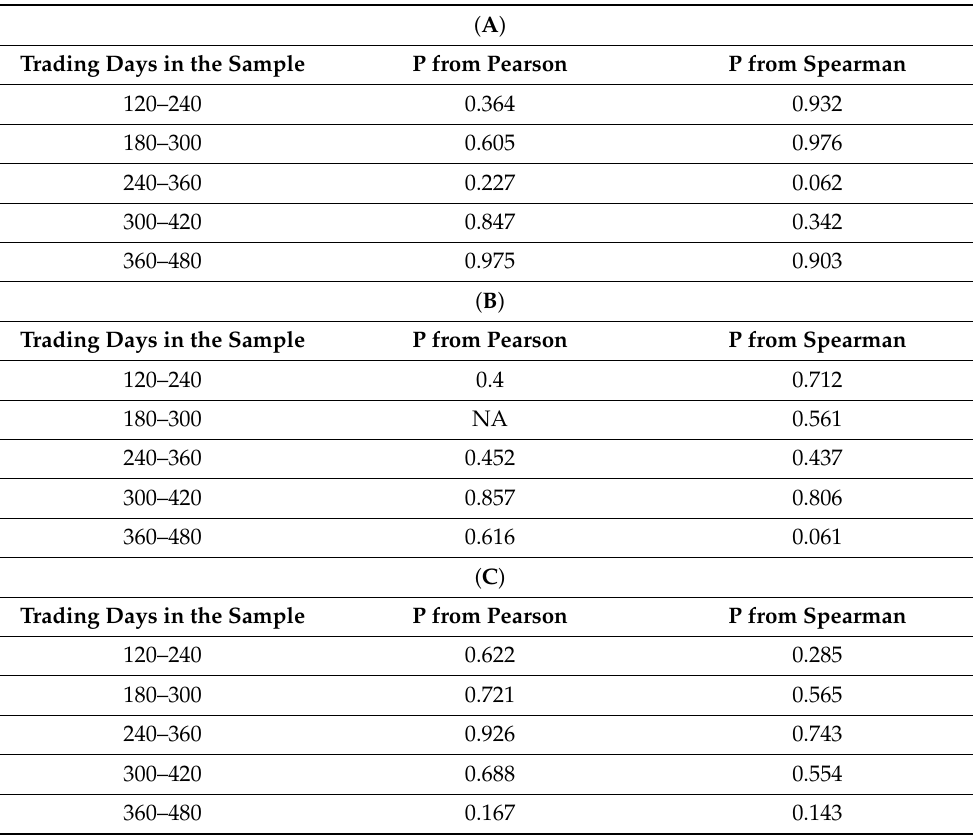
Table 5. Probabilities of null hypothesis H1 from a typical correlation test of index predictions from Amihud λ